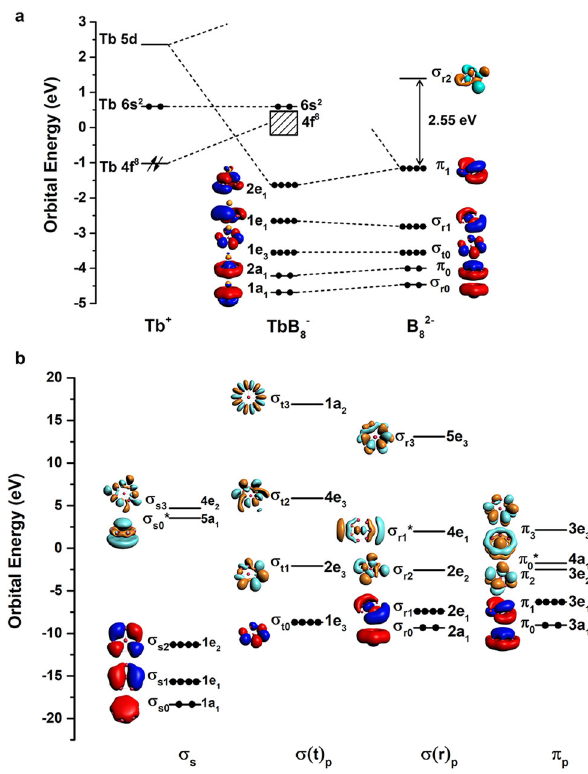
Fig. 3 Chemical bonding and orbital interactions. a Orbital correlation diagram of the C 7v TbB 8 − with those of Tb + (4 f 8 6 s 2 ) and B 8 2 − at the PBE/ TZP level. Similar diagrams for La/PrB 8 − and Tm/YbB 8 − are given in Supplementary Fig. 5. The dashed lines show the major contribution to the orbital interactions. The arrows on the 4 f orbitals represent f 8 occupied electrons. The occupied 4 f bands in TbB 8 − are indicated by the slash solid lines. b The local coordinate system (LCS) analysis for the C 7v B 8 2 − ligand at the PBE/DZP level. The 32 valence orbitals of 2 s /2 p characters are categorized into four groups. Herein, “ t ” and “ r ” represent “ tangential ” and “ radial ” , respectively. The subscript number corresponds to the nodal plane of the orbital contour. The superscript * indicates antibonding orbitals between the central B atom and the peripheral delocalized